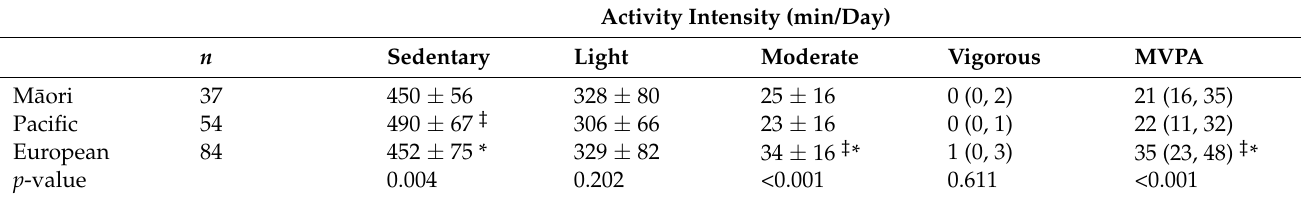
Table 2. Physical activity and sedentary data for